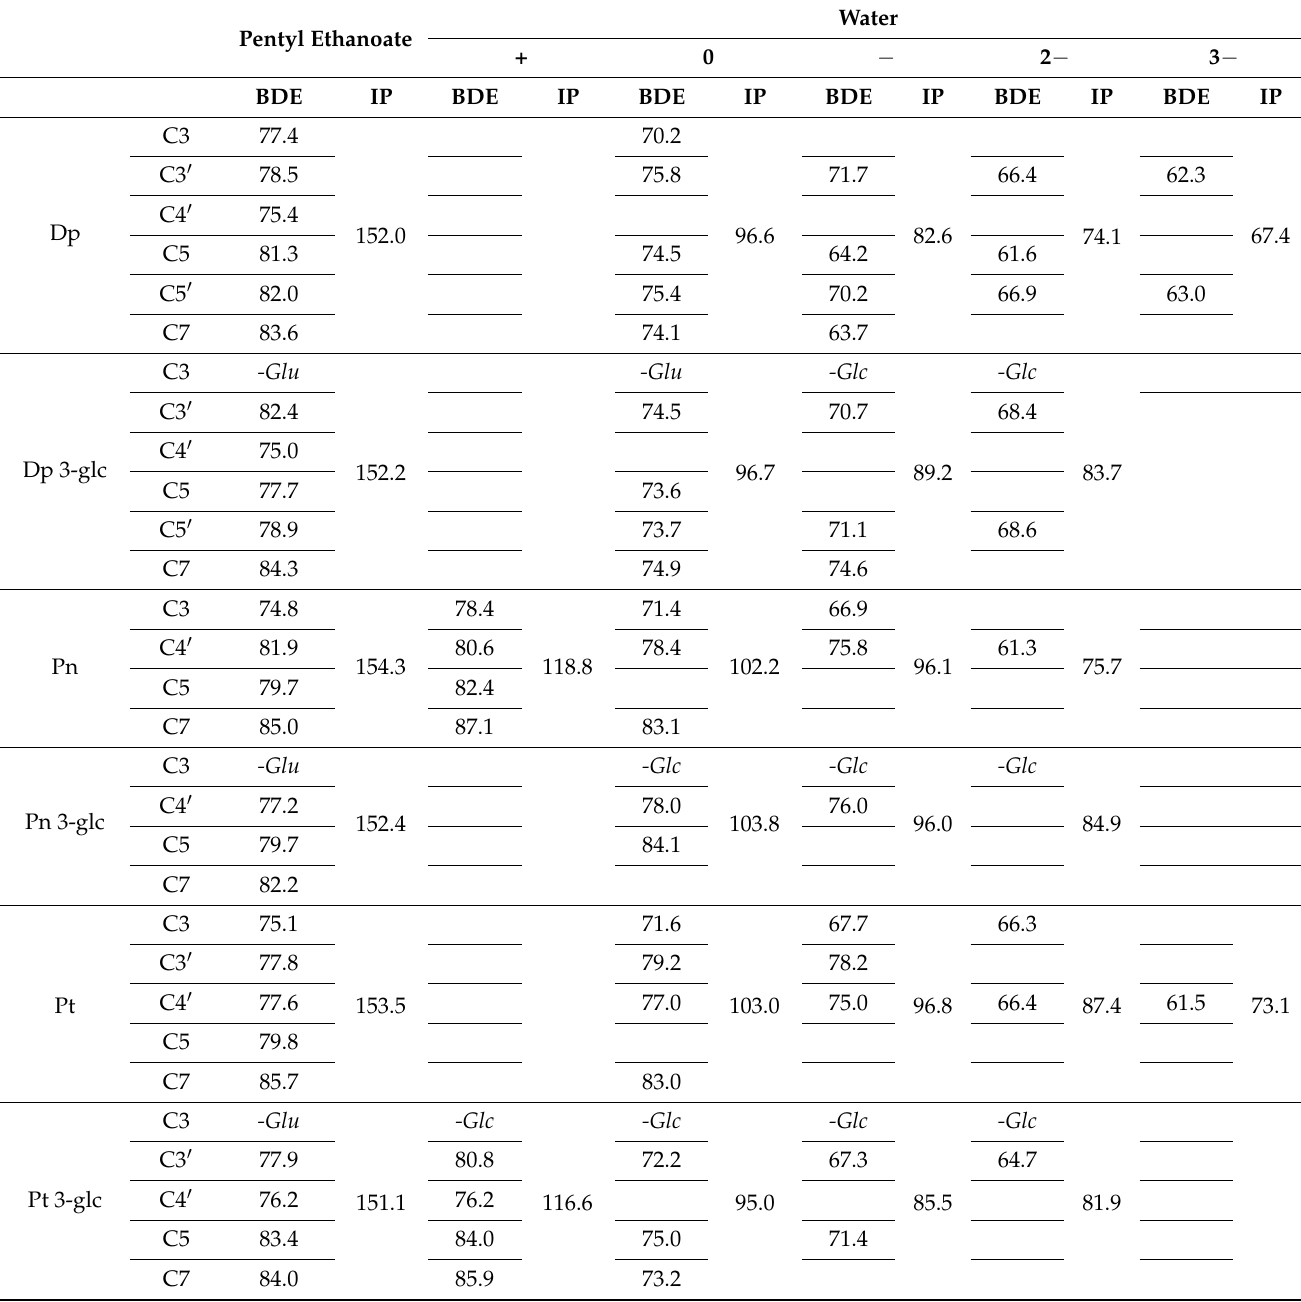
Table 3. Intrinsic reactivity indices (in kcal mol − 1 ) of the species with non-negligible populations of the investigated compounds; the lowest values are highlighted by bold